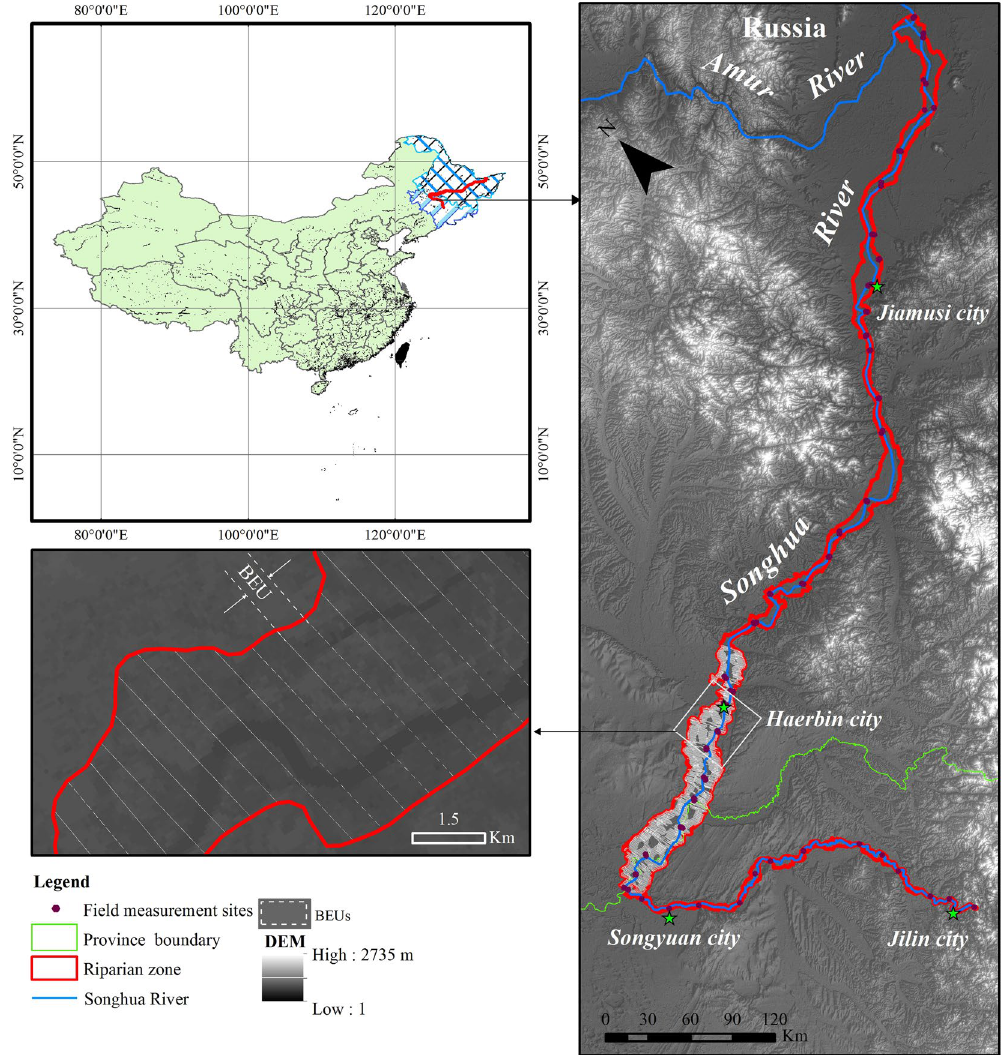
Figure 1. This figure illustrates the study area and field measurement sites in the Northeast China. The riparian zone was divided into 13 measurement sections, and each measurement section was partitioned into basic evaluation units (BEUs).The base map (right) is the Shuttle Radar Topography Mission 1 arc-second global DEM (U.S. Geological Survey, National Geospatial-Intelligence Agency and National Aeronautics and Space Administration, 2000, Shuttle Radar Topography Mission 1 Arc-Second Global, Sioux Falls, South Dakota.: U.S. Geological Survey (USGS) Earth Resources Observation and Science (EROS) Center, https://lta.cr.usgs.gov/ SRTM1Arc). ArcGIS 10.3 software (http://www.esri.com/software/arcgis) was used to develop the